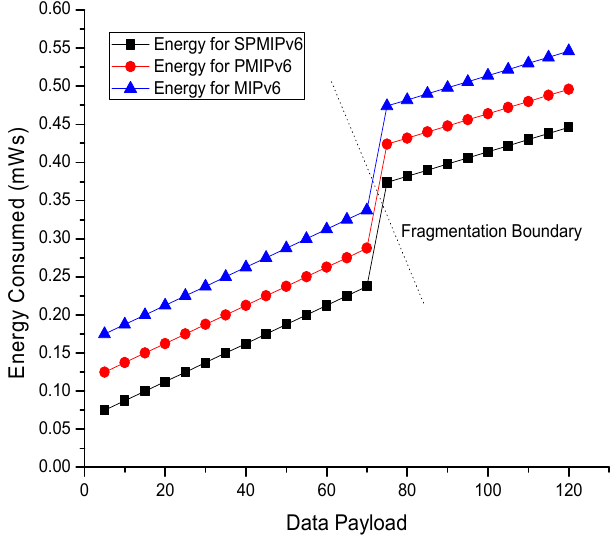
Figure 19. Data payload vs. Energy